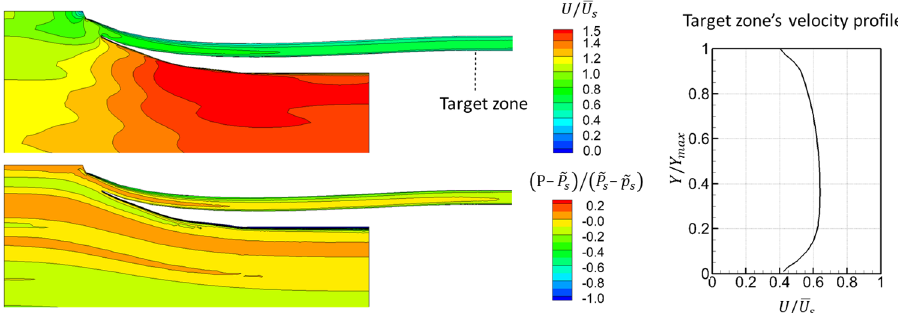
Figure 18. Selected design of DoE 1, a7b1c7.